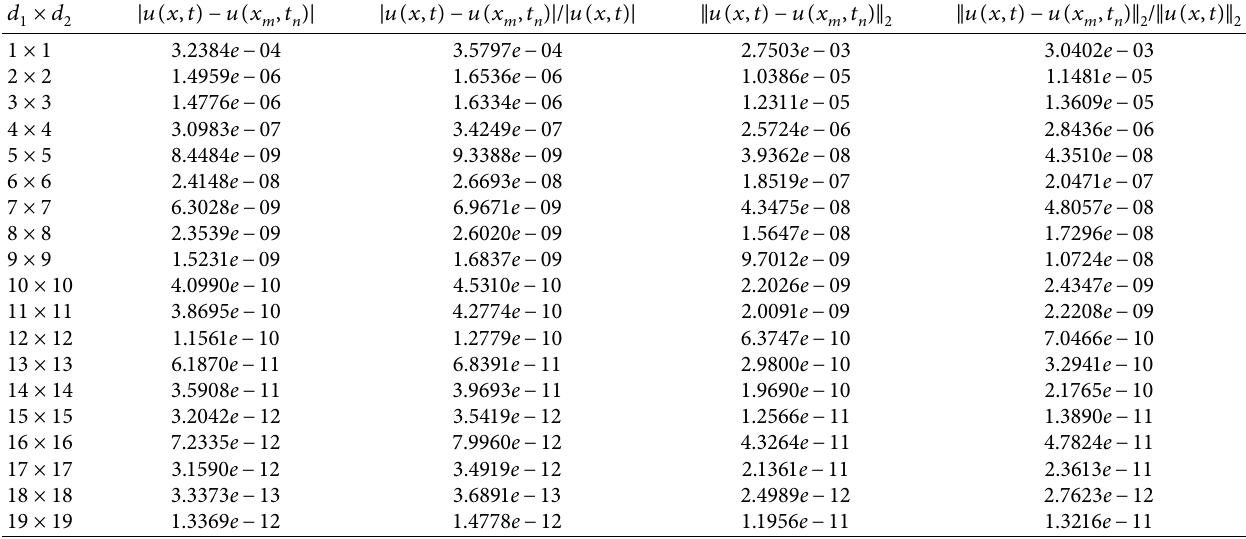
Table 1: Errors of the barycentric rational collocation methods in the case of Chebyshev nodes with m × n � 20 × 20 for Example 1. × d d 1 2